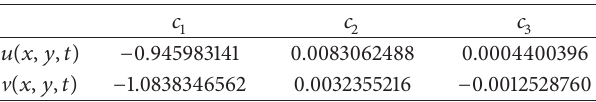
Table 1: Convergence control parameters of example for 𝑢(𝑥,𝑦,𝑡) and V (𝑥,𝑦,𝑡) .